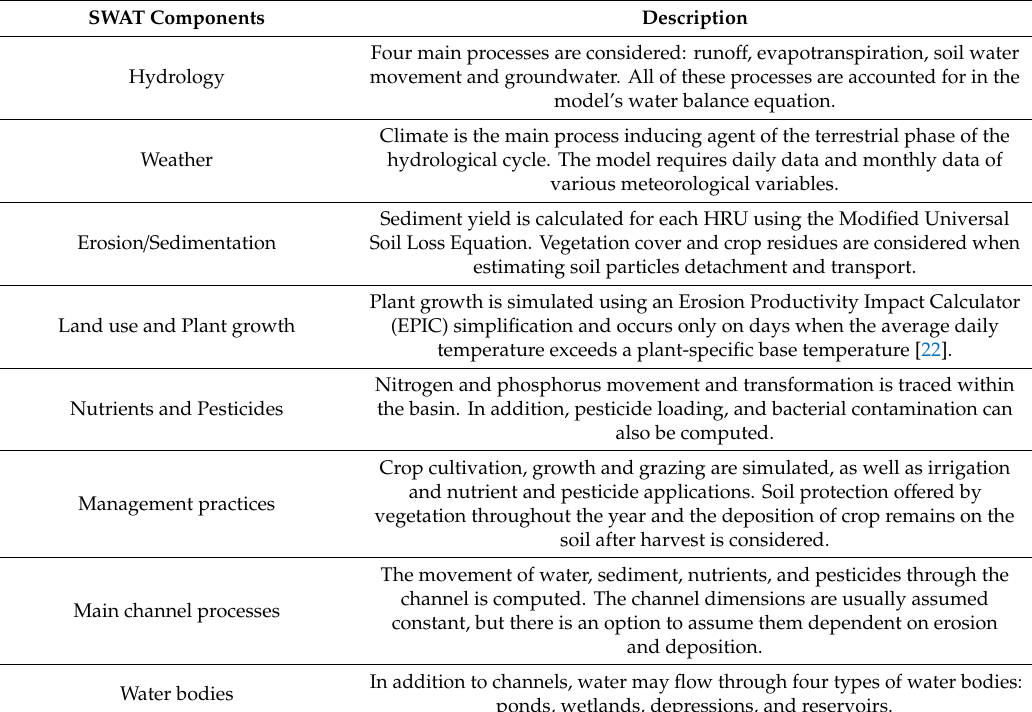
Table 1. Soil Water Assessment Tool (SWAT)